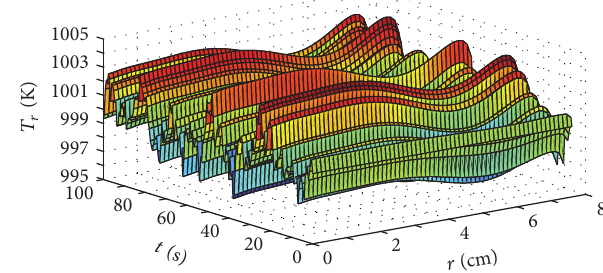
Figure 9: The measured wafer temperature with perturbed